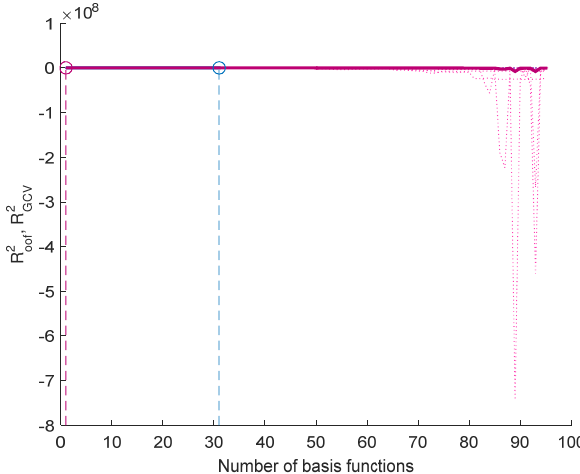
Fig. 4. Plot of cross-validation results